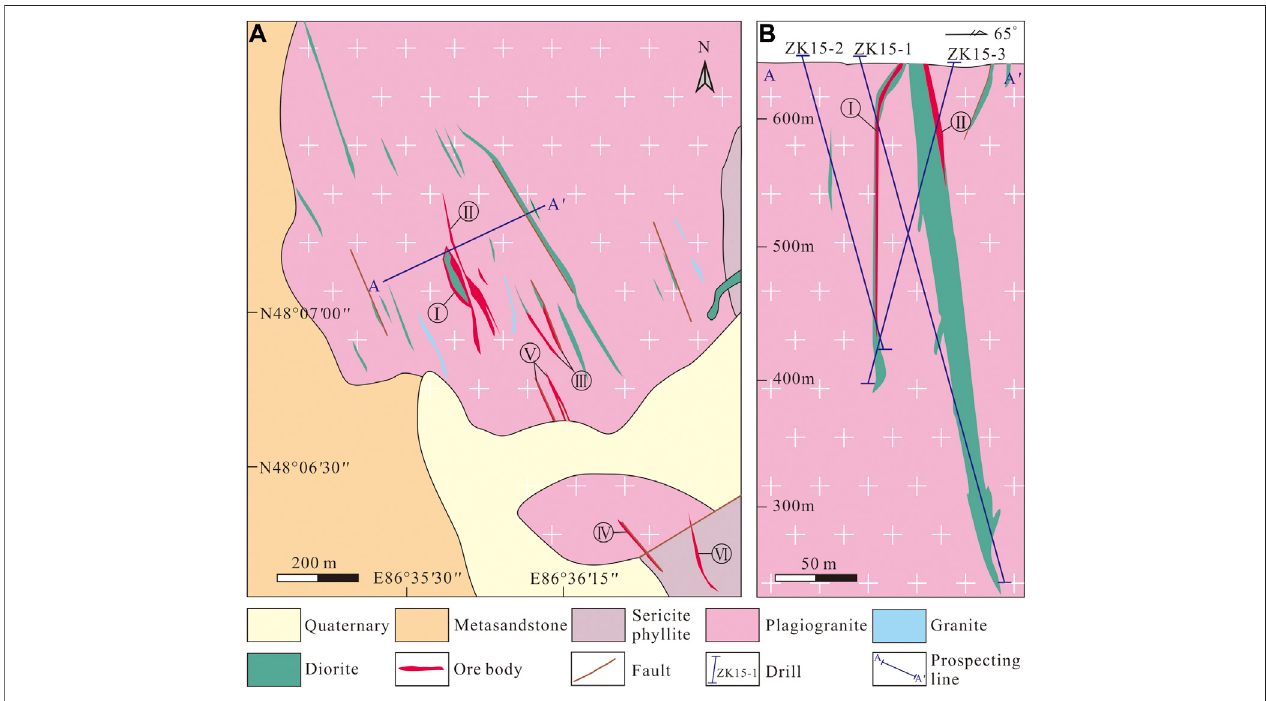
FIGURE 2 | (A) Geological map of the Jinba gold deposit (modi fi ed after Wang et al., 2018). (B) Geological cross – section of the orebodies (modi fi ed after Wang et al., 2018).